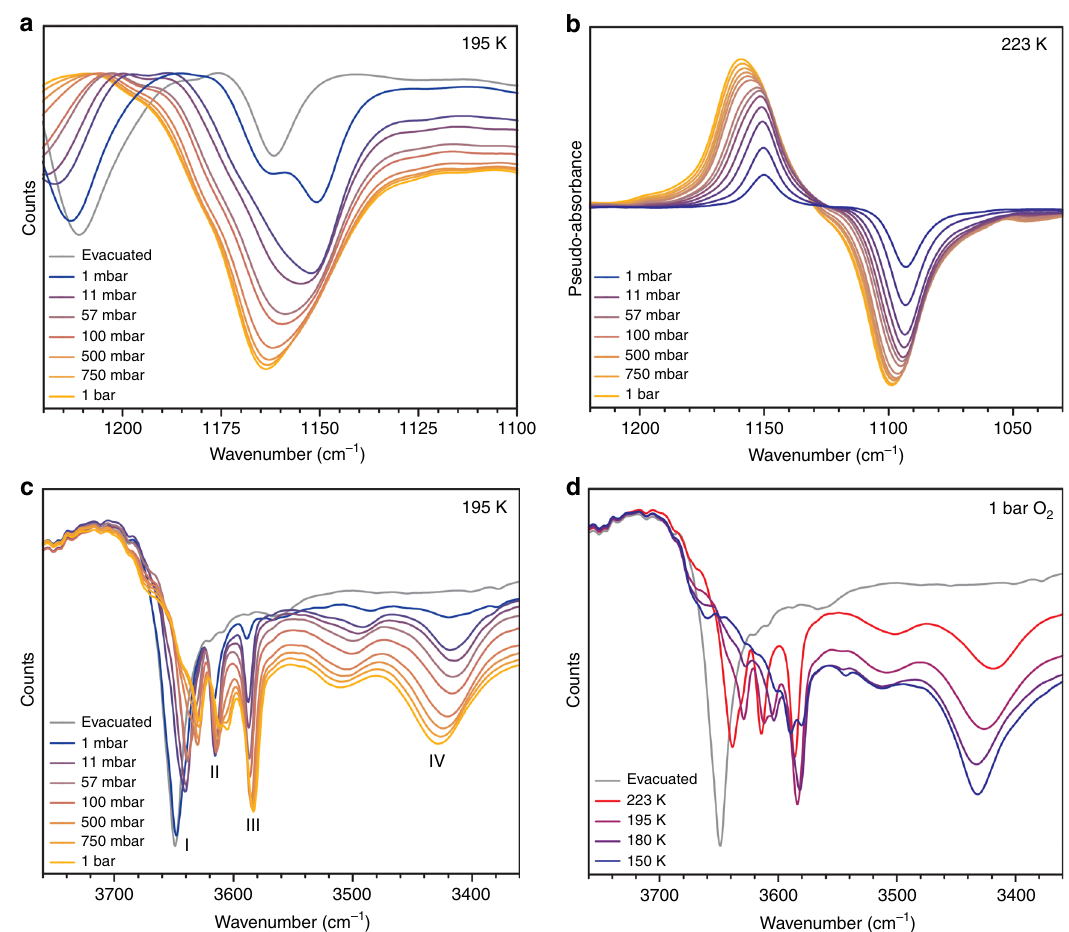
Fig. 5 Spectroscopic data for evacuated and O 2 -dosed Co 2 (OH) 2 (bbta). a Raw DRIFTS data obtained at 195 K by dosing Co 2 (OH) 2 (bbta) with variable pressures of 16 O 2 . b DRIFTS spectra obtained at 223 K for Co 2 (OH) 2 (bbta) dosed with increasing pressures of 16 O 2 , subtracted from the spectra of Co 2 (OH) 2 (bbta) dosed with corresponding pressures of 18 O 2 . The ν (O – O) band of the adsorbed superoxo species appears as a positive peak for 16 O 2 and a negative peak for 18 O 2 . c Raw DRIFTS spectra obtained at 195 K for desolvated and 16 O 2 -dosed Co 2 (OH) 2 (bbta). The broad ν (OH) band from 3416 – 3427 cm − 1 (IV) is assigned to a cobalt(III)-hydroxo hydrogen bonded to the proximal oxygen atom of an adsorbed superoxo species. Sharper peaks (I – III) correspond to additional framework hydroxo groups, as indicated in Supplementary Fig. 54. d Raw DRIFTS spectra obtained at 223 K for desolvated Co 2 (OH) 2 (bbta) and for Co 2 (OH) 2 (bbta) dosed with 1 bar of 16 O 2 obtained at 223, 195, 180, and 150